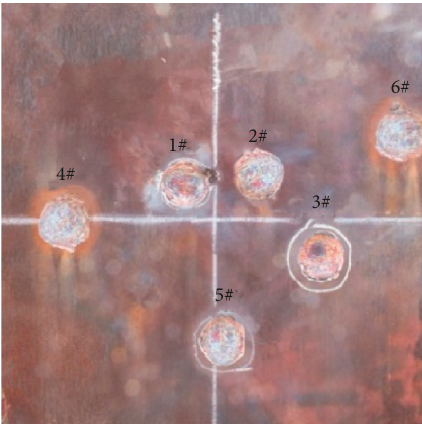
Figure 9: EFP landing points for tests